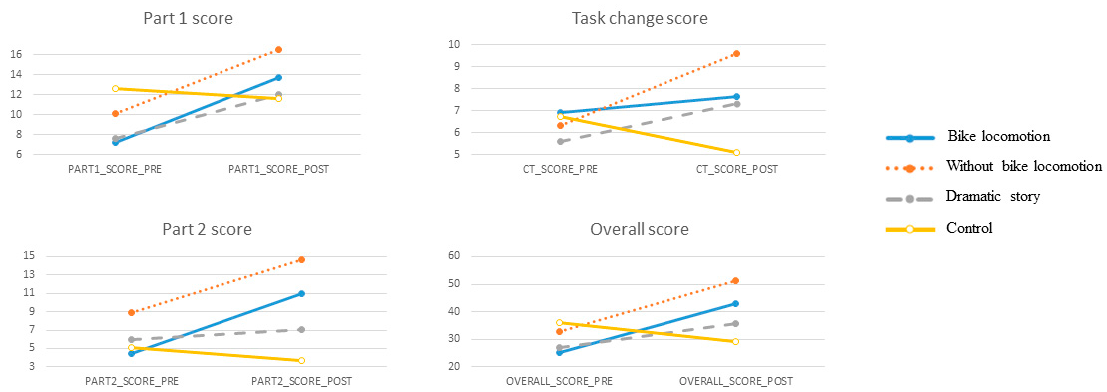
Figure 2. Group e ff ect pre-post score in the di ff erent parts of the head, toes, knees and shoulders Figure 2. Group effect pre-post score in the different parts of the head, toes, knees and shoulders (HTKS) test. (HTKS) test.